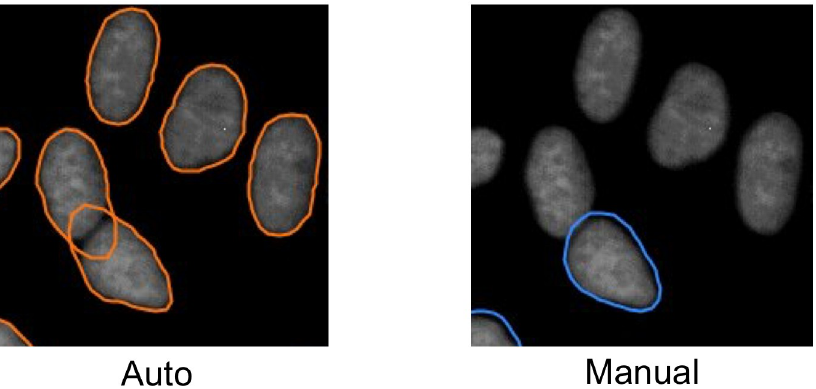
Fig 5. Adaptability of an automatically and manually annotated dataset for nuclei segmentation. Applying automated annotation to an individual dataset and training these data with a neural network provides accurate segmentation results. Nuclei segmentation performs poorly when relying on the training dataset acquired with lower magnifications. To achieve accurate segmentation a time-intensive manual annotation process is required.